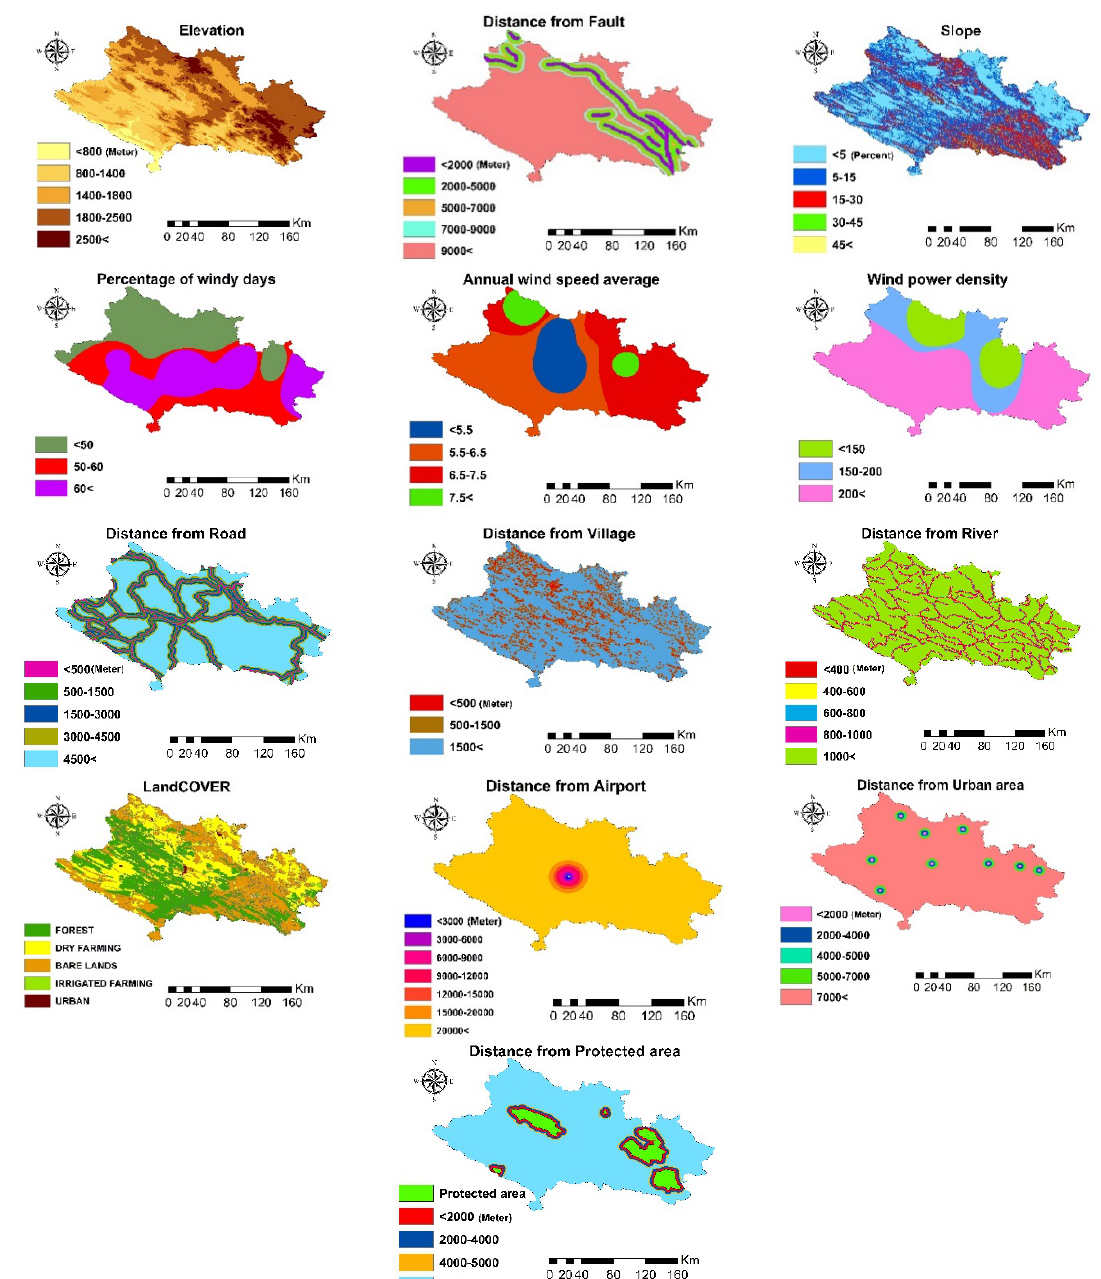
Figure 6 . Input data layers in wind power plant site selection for Lorestan Province The final land suitability map for wind power plant development is shown in the Figure 7. Overlapping layers were zoned into five classes: less suitable, suitable, moderate suitable, high suitable and extremely